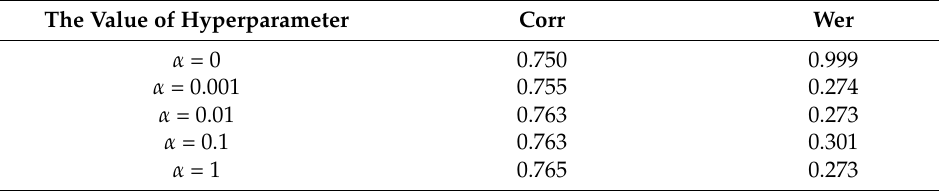
Table 9. The impact of the CTC loss on Speechocean762